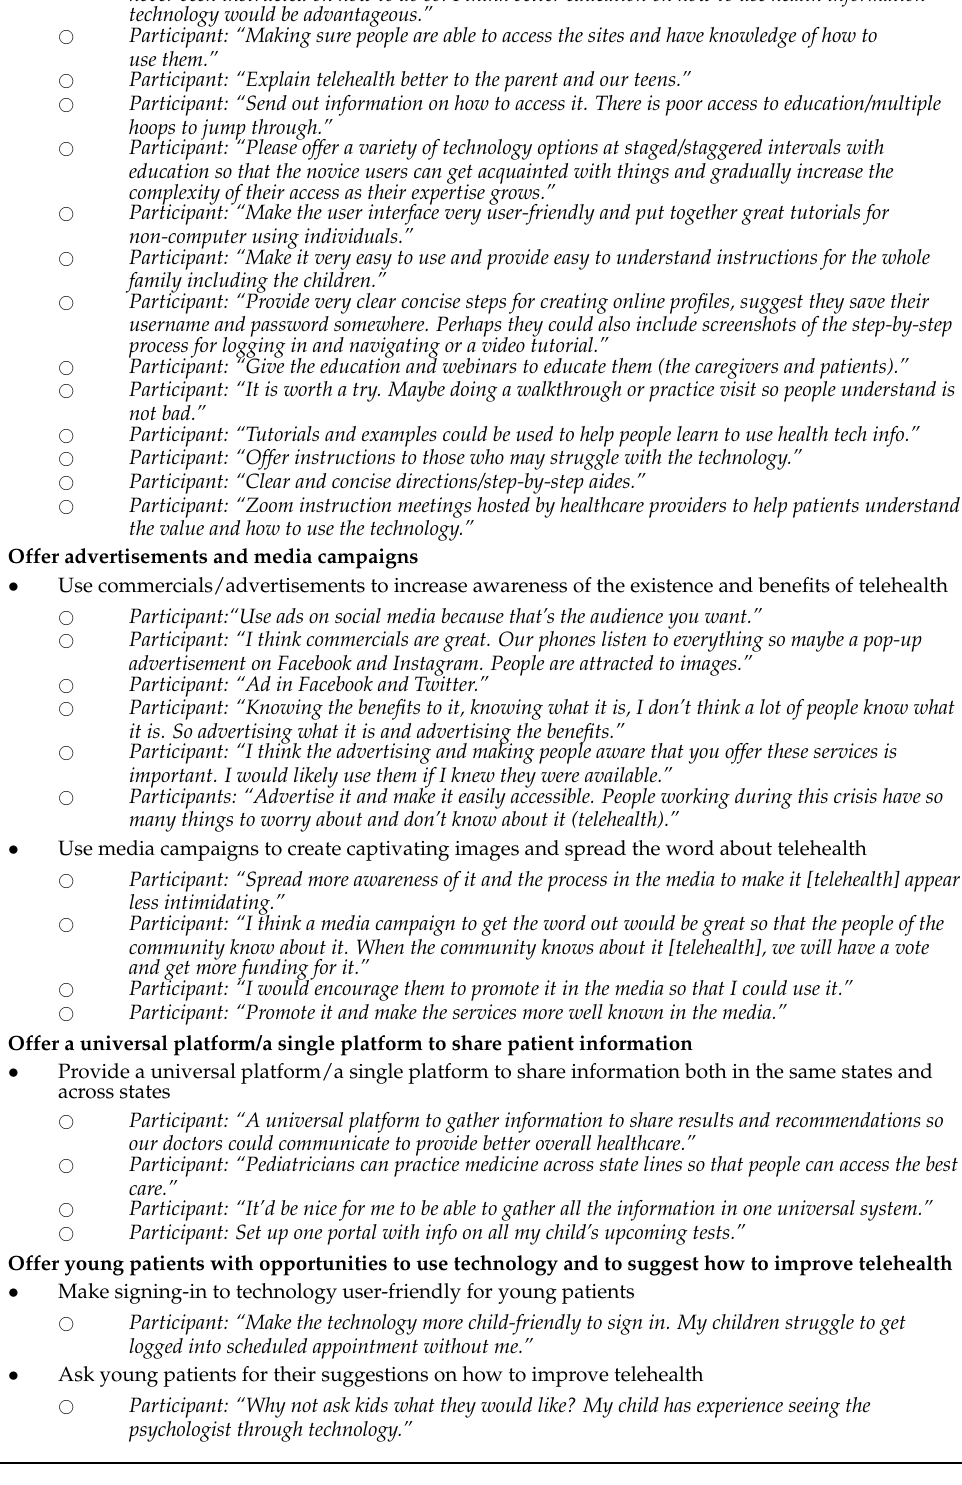
Study Population, N =